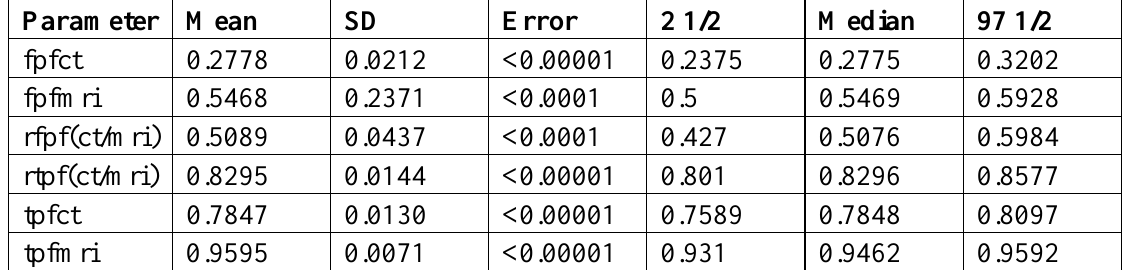
Table 11. Posterior analysis for CT and MRI imaging for lung